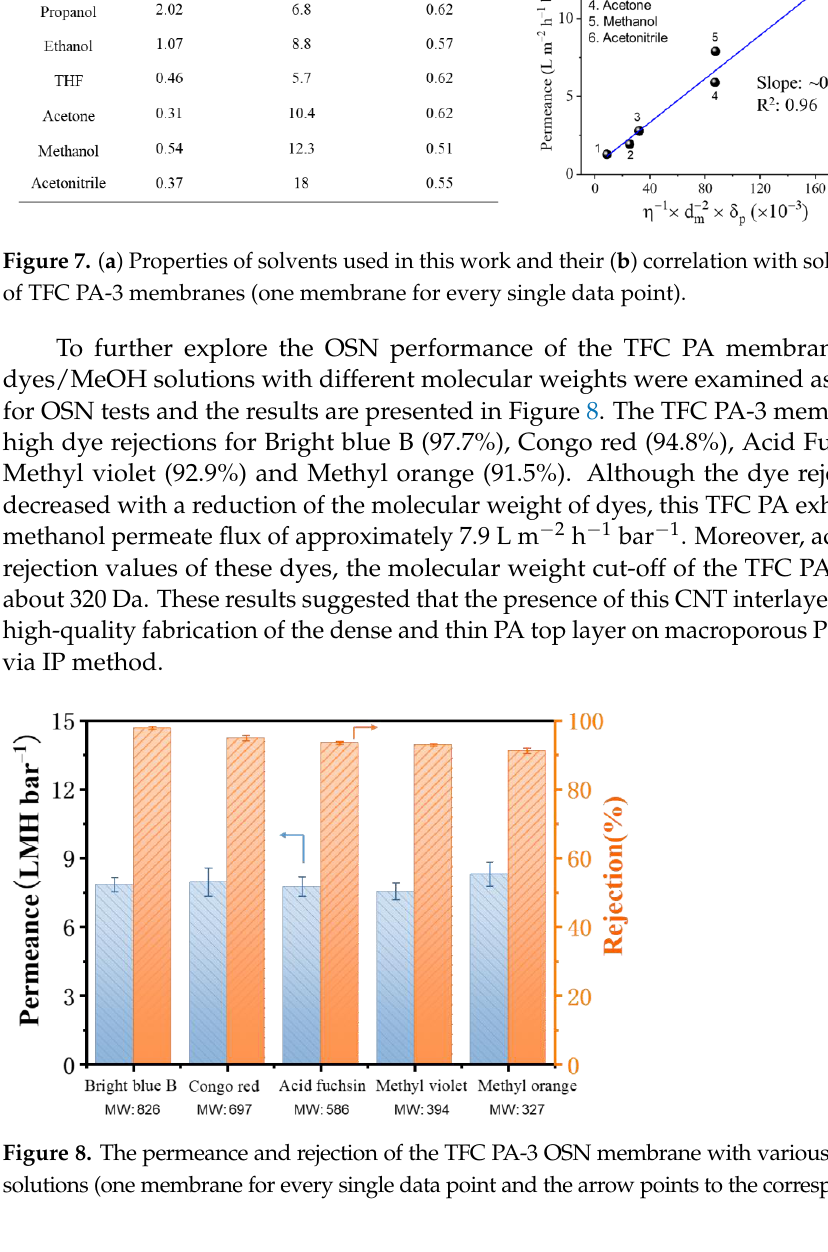
Figure 8. The permeance and rejection of the TFC PA-3 OSN membrane with various dyes/methanol solutions (one membrane for every single data point and the arrow points to the corresponding Y- axis). Figure 9 shows the long-term time course for OSN performance of the TFC PA-3 membrane for filtrating 20 ppm Methyl orange/MeOH solution. This triple-layered TFC PA membrane exhibited a high Methyl orange rejection (~92%) and constant methanol flux of approximately 8.0 L m − 2 h − 1 bar − 1 after 24h continuous OSN test. This result showed that the triple-layered TFC PA membrane had an excellent long-term stability and OSN